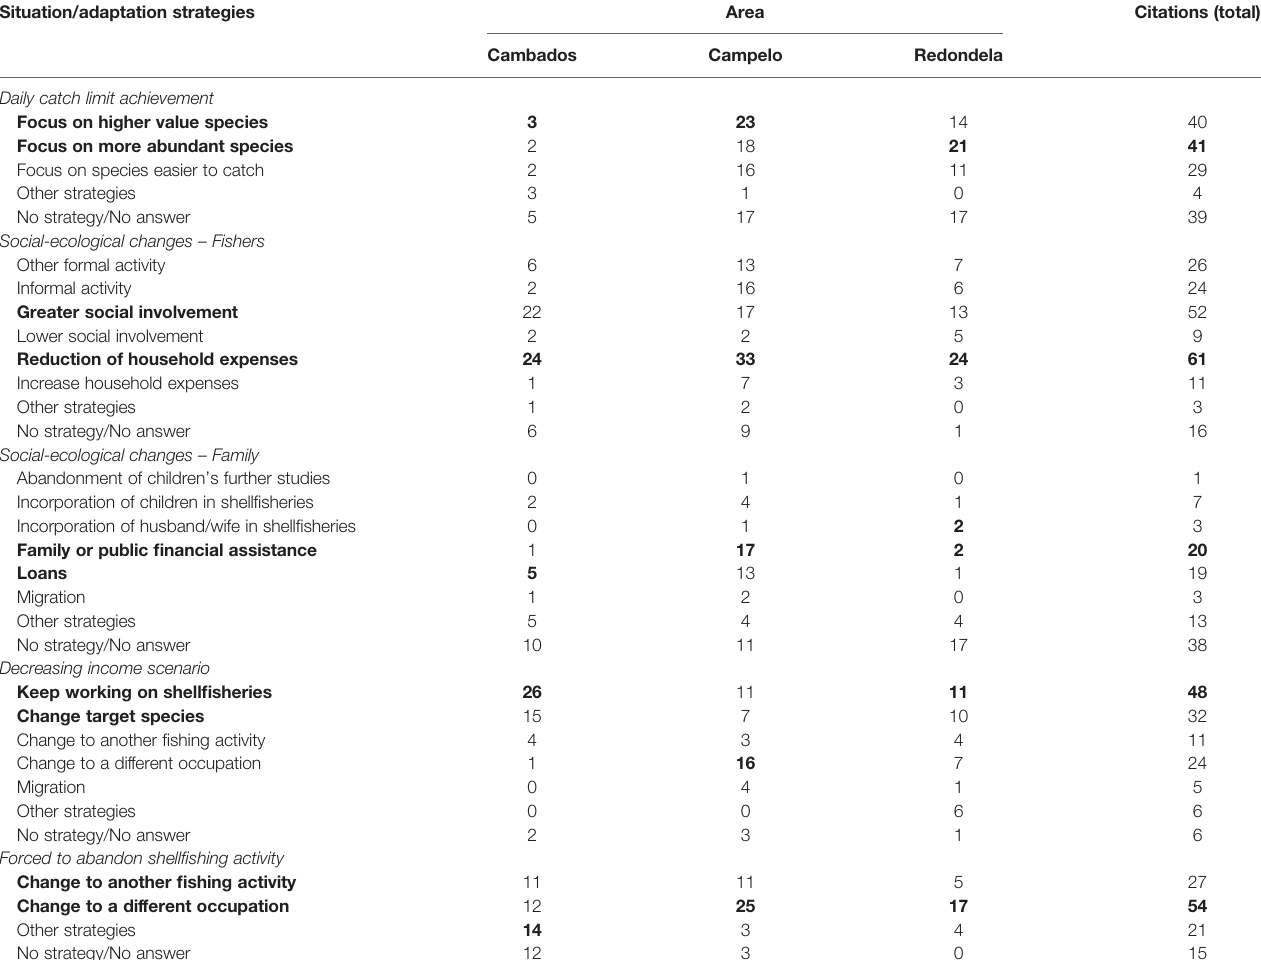
TABLE 2 | Situations and adaptation strategies cited by fi shers in each study area: Cambados, Campelo and Redondela. Situation/adaptation